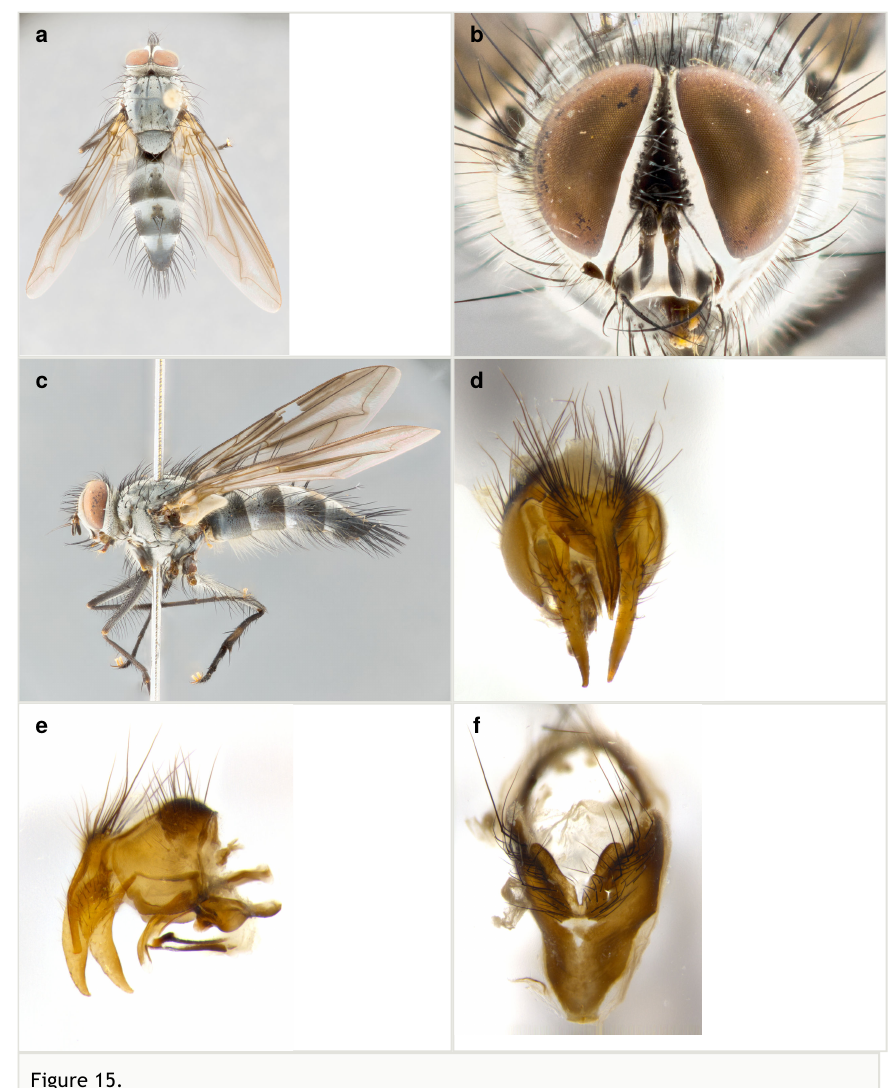
Uramya pannosa sp. nov. ; a-f : holotype male; voucher n.